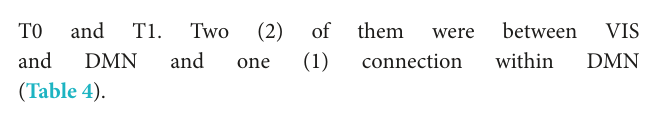
fourteen (14) connections emerging in pairwise comparisons were found between different RSNs involving mainly DMN, FPN, and SMN networks, while one (1) edge was observed within visual and one (1) within DMN networks respectively ( Table 3